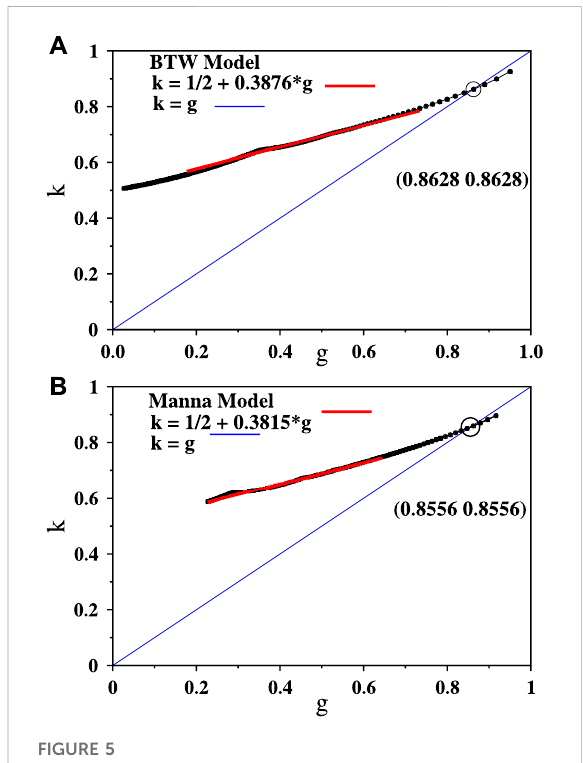
FIGURE 5 Kolkataindex k againstGiniindex g plottedfor (A) BTWmodel and (B) Manna model. The initial slope of the simulation data fi ts well with the relation k = 0.5 + C * g ( C = 0.385 ± 0.005) and g c = k c = 0.860 ± 0.005 is the crossing point with the g = k line. Taken from Ref.